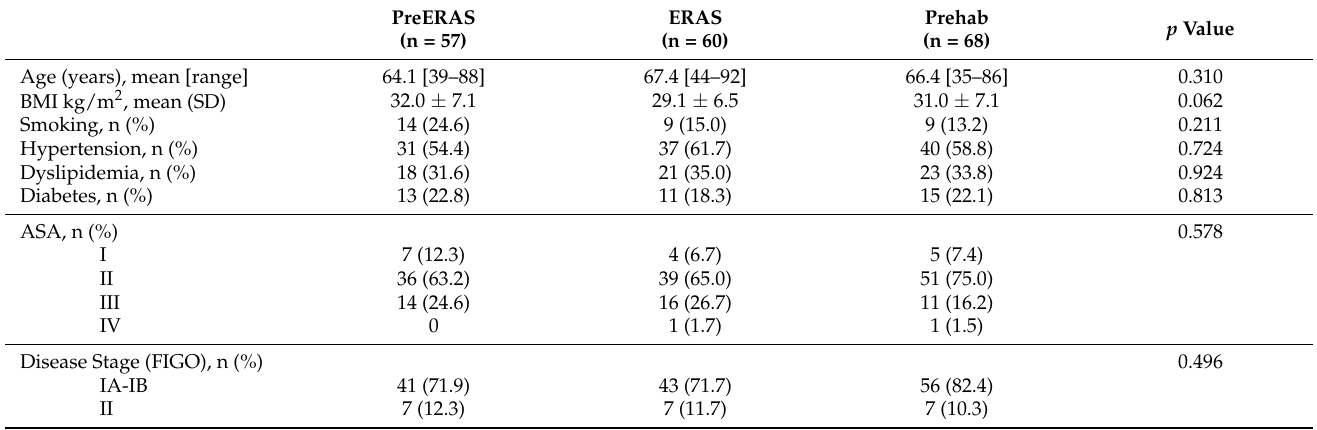
Table 1. Baseline patients’ characteristics according to the followed perioperative program. PreERAS (n =